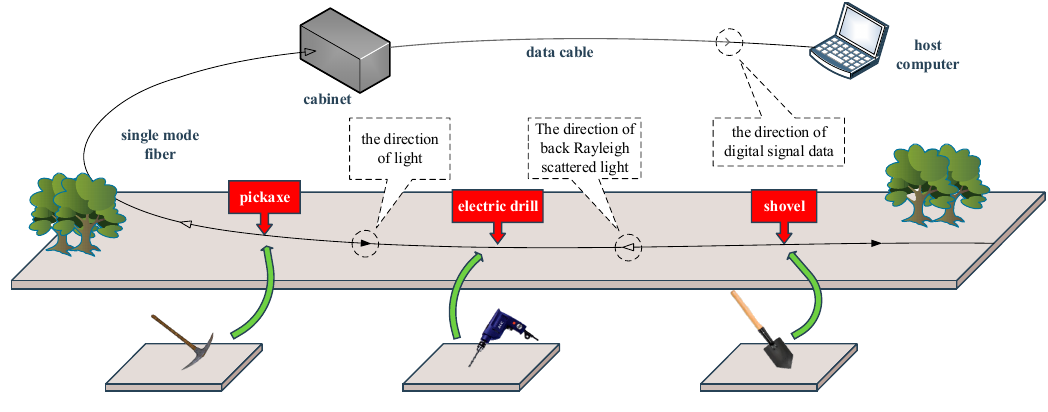
Figure 5. The schematic diagram of the OFPS.